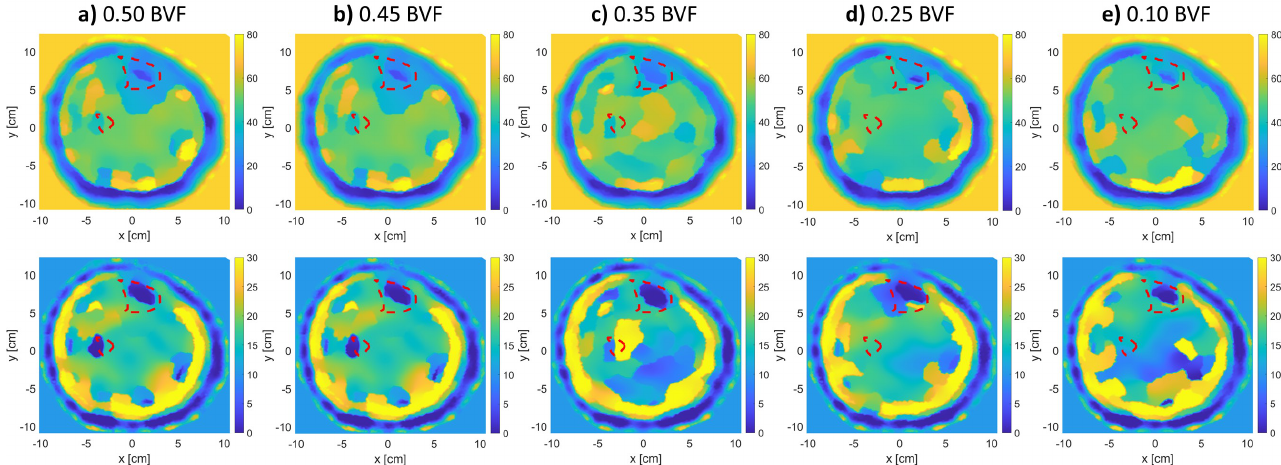
Figure 9. Relative complex permittivity reconstructions for leg model 2 with varying BVFs ( top row : real, bottom row : imaginary). The red-dotted lines indicate the bones’ actual